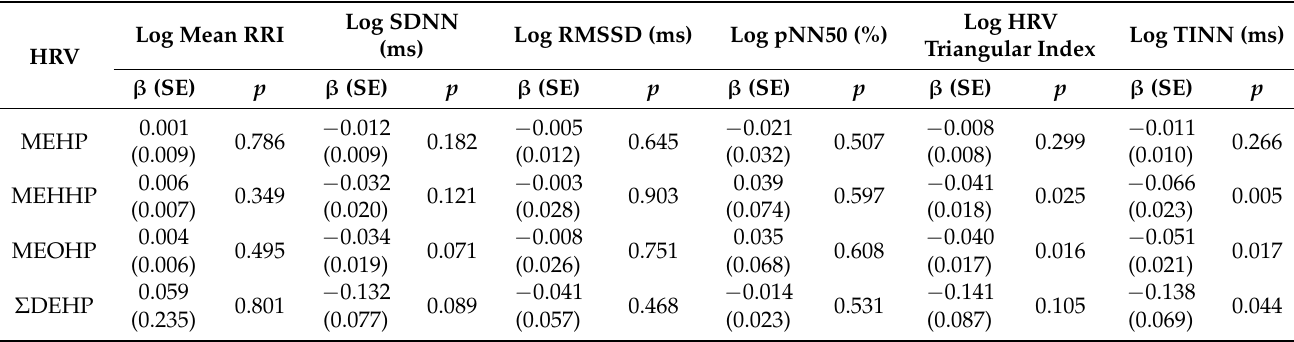
Table 2. Univariable linear regression of urinary phthalate metabolites and time-domain heart rate variability (HRV) analysis parameters.